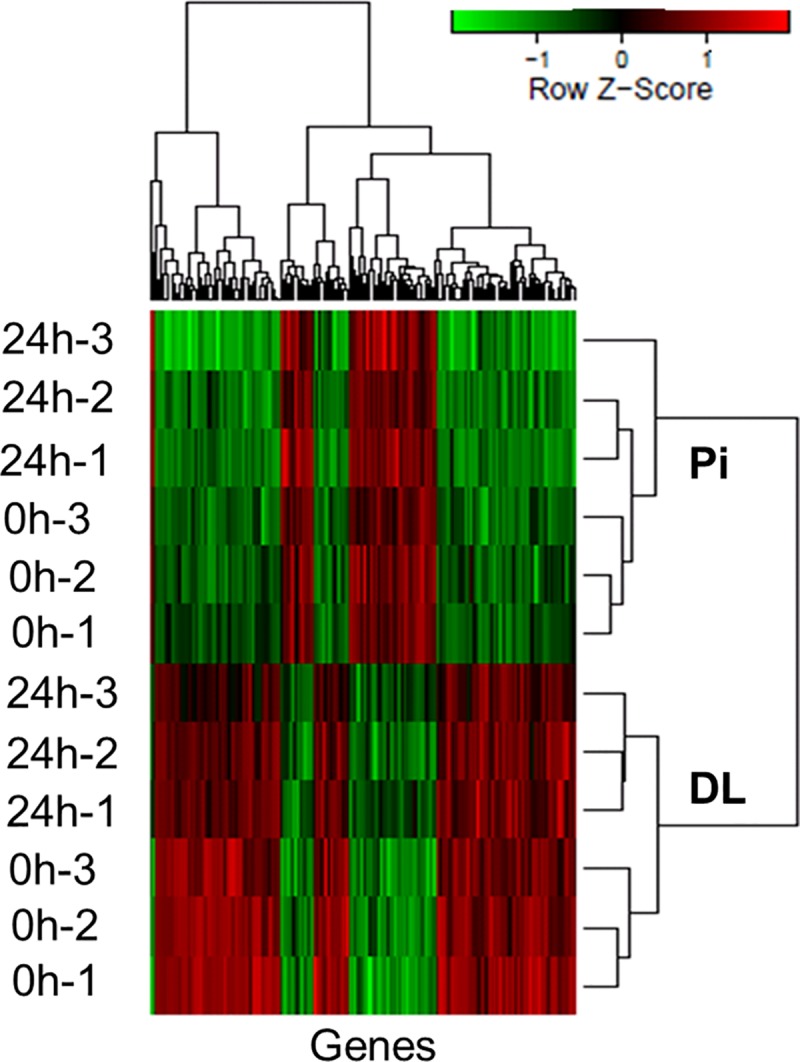
Hierarchical heat map showing differential gene expression over the contrast pairs.The figure includes DEGs between vaccinated PBMCs of DL pigs compared to that of Pi pigs. The normalized log2 transformed values determined by Affymetrix GeneChip porcine gene 1.0 ST array in PBMCs collected at 0 and 24 h post PRRSV vaccination both in DL and Pi pigs. The cutoff values of log2 fold change as either >1.5 or <-1.5 and FDR <0.05 were considered for statistical significance. Each column represents one array from each of replicate piglets.